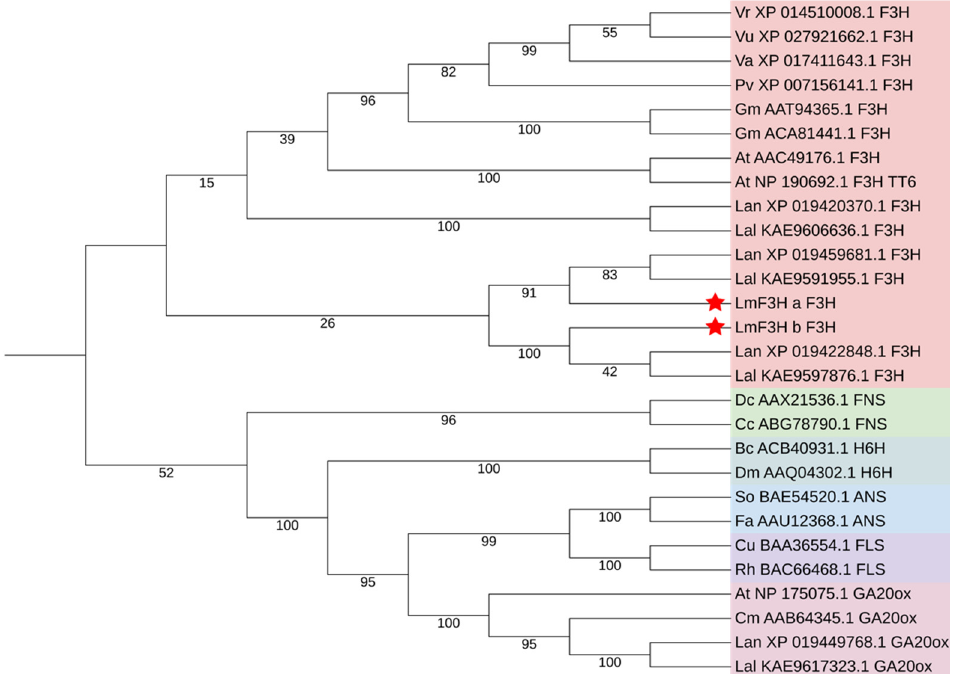
Figure 4. Phylogenetic tree illustrating similarity between Lupinus mutabilis polypeptide sequences LmF3h_a and LmF3h_b (red stars) and other F3H proteins from other Lupinus species, other F3H protein sequences from several Fabaceae species and from Arabidopsis thaliana including TT6, as well as to flavone synthase (FNS), anthocyanidin synthase (ANS), flavonol synthase (FLS), hyoscyamine 6 β -hydroxylase (H6H) and gibberellin 20 oxidase (G20ox) of other different species. At—